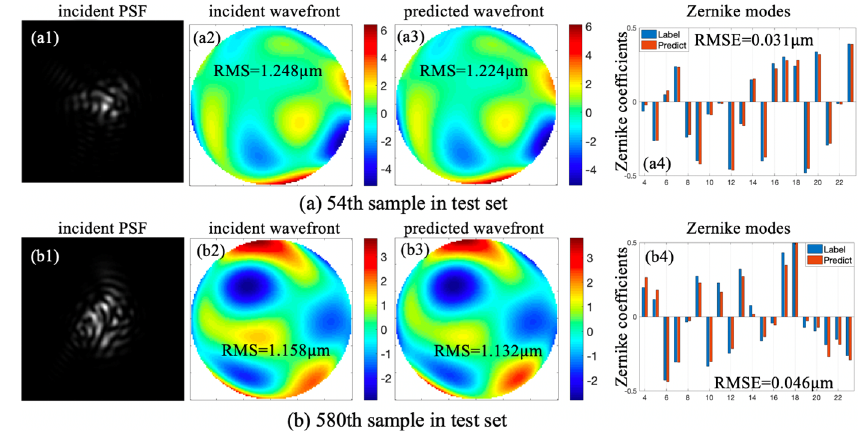
Figure 9. Reconstruction results of 54th ( a ) and 580th ( b ) samples in the test set.